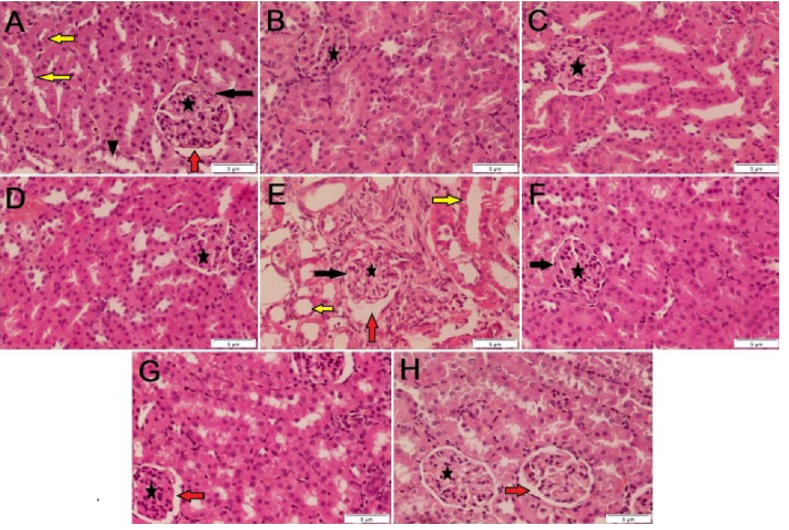
Figure 6. Histological evaluations of kidney sections in all studied groups. The control group ( A ) showed a normal structure of the renal corpuscle (asterisk) and renal tubules, proximal convoluted tubules (yellow arrow), and distal convoluted tubules (arrowhead). Notice the glomerulus (asterisk), urinary space (red arrow), and Bowman’s capsule (black arrow). The GA group ( B ), the CMCS group ( C ), and the GA@CMCS group ( D ) all show a normal structure of the renal corpuscle (asterisk) and renal tubules. The CDDP group ( E ) showed the cortical tubules have become shrunken and atrophic and have relatively expanded interstitial spaces. Fibrosis and atrophy of the glomerulus are seen. Notice the glomerular basement membrane is diffusely and fairly uniformly thickened. The (CDDP + GA) group ( F ), the (CDDP + CMCS) group ( G ), and the (CDDP + GA@ CMCS) group ( H ) show the structure of the renal corpuscle (asterisk) and renal tubules appear more or less normal. (H & E stain, scale bar: 5